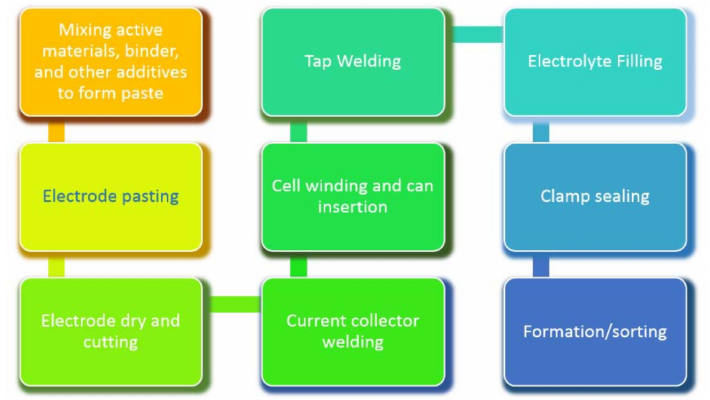
Figure 4. A flow chart showing the Ni/MH battery fabrication processes of a typical